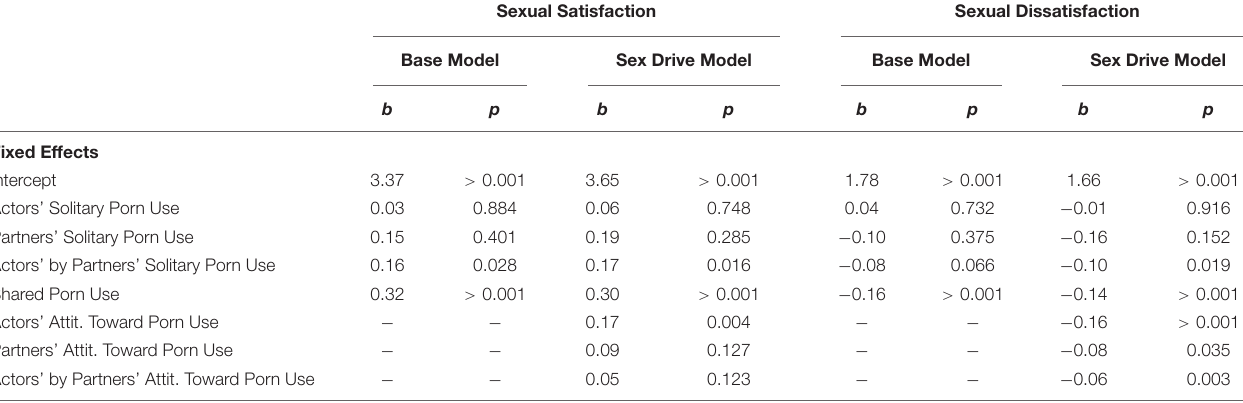
TABLE 11 | Testing potential confounding effect of differences in actors’ and partners’ attitudes toward pornography in Study 4 ( N = 233